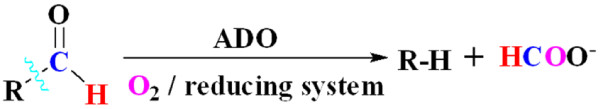
ADO-catalysed reaction [[8],[12]-[16]]. Oxygen and the auxiliary reducing system (biological or chemical) providing four electrons are needed for ADO activity, one O-atom is incorporated into formate, and the aldehyde hydrogen is retained in formate.